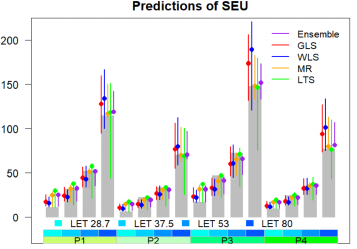
Figure 5. Evaluations, 95% confidence intervals and real values of the five methods on the training